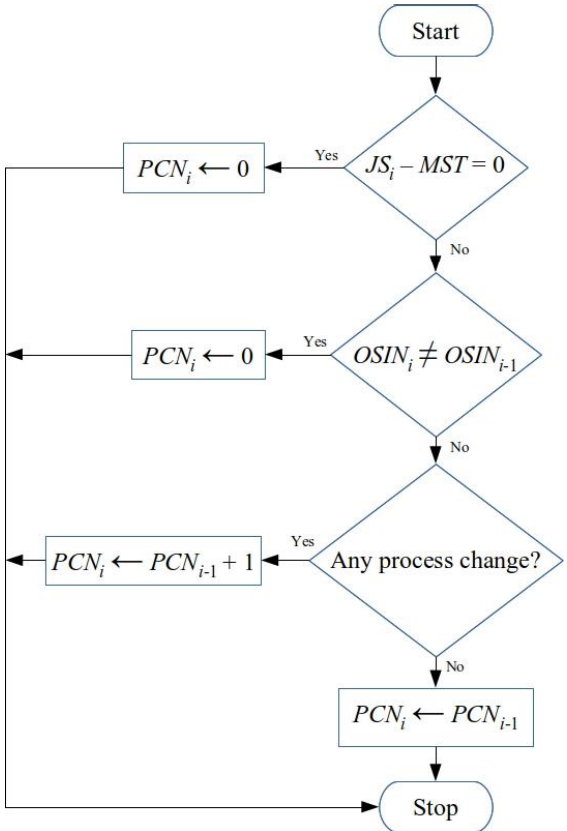
Figure 3. Supply appropriate values for the PCN field